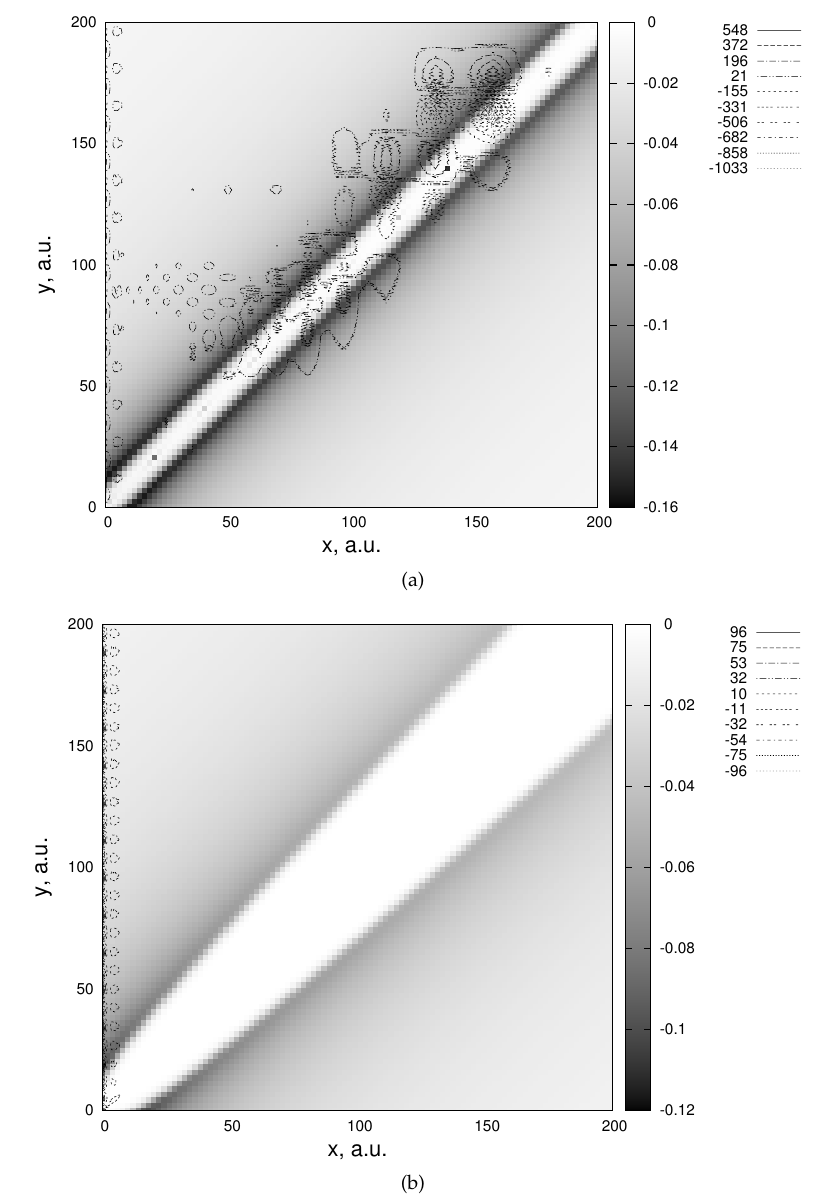
Figure 5. Faddeev components of the wave function (contours) drawn over the long-range part of the Coulomb potential (background density plot). The numbers in the columns at the right hand side of each plot indicate the component values along the contour lines. ( a ) The component corresponding to the instability at higher energies as the solution starts to leak out along the long-range part of the potential corresponding to the second pairing; ( b ) The proper asymptotic behavior at higher energy is ensured by splitting the potential in the three-body configuration